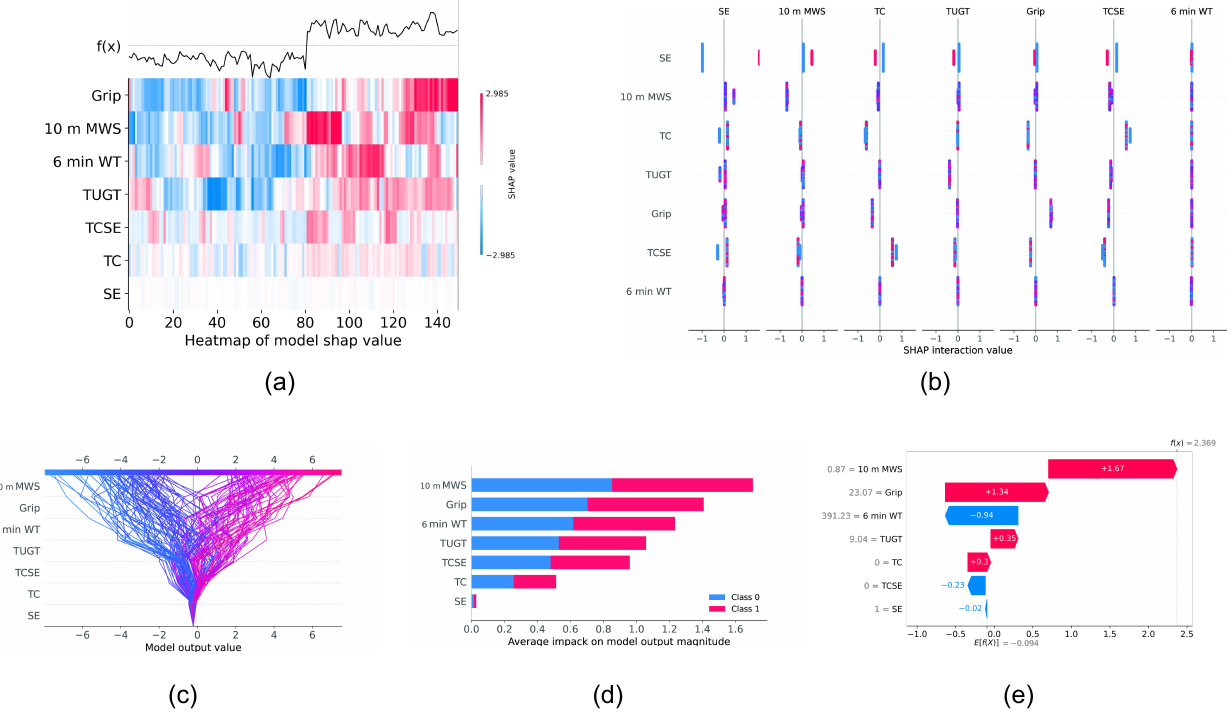
Figure 5. A summary plot of the SHAP values for each feature. The y-axis denotes the different features. ( a ) Indicates the heat map of different feature SHAP values, where the x -axis indicates the sample sequence, red indicates positive influence, and blue indicates negative influence; the darker the color, the greater the degree of influence. f(x)p indicates the output (before activation function). The figure shows that the most important feature has a positive effect if the output is positive and also indicates that there is a clear boundary (threshold) in the features. ( b ) denotes the interaction SHAP values of different features, revealing the interaction effects between different features. ( c ) denotes an overview of the features that are most important for a model and how the model obtained the output of every feature for every sample, where the x -axis denotes the model- predicted values. ( d ) denotes the average absolute SHAP value of different features; the x -axis denotes the average SHAP value. The ten-meter maximum walking speed contributed the most to predicting the frailty state. ( e ) represents features contributing to pushing the model output from the base value of a single sample, where the x -axis represents the SHAP value. In this case, the ten-meter maximum walking speed contributed the most positive effect, and the six-minute walk test contributed the most negative effect for predicting the frailty